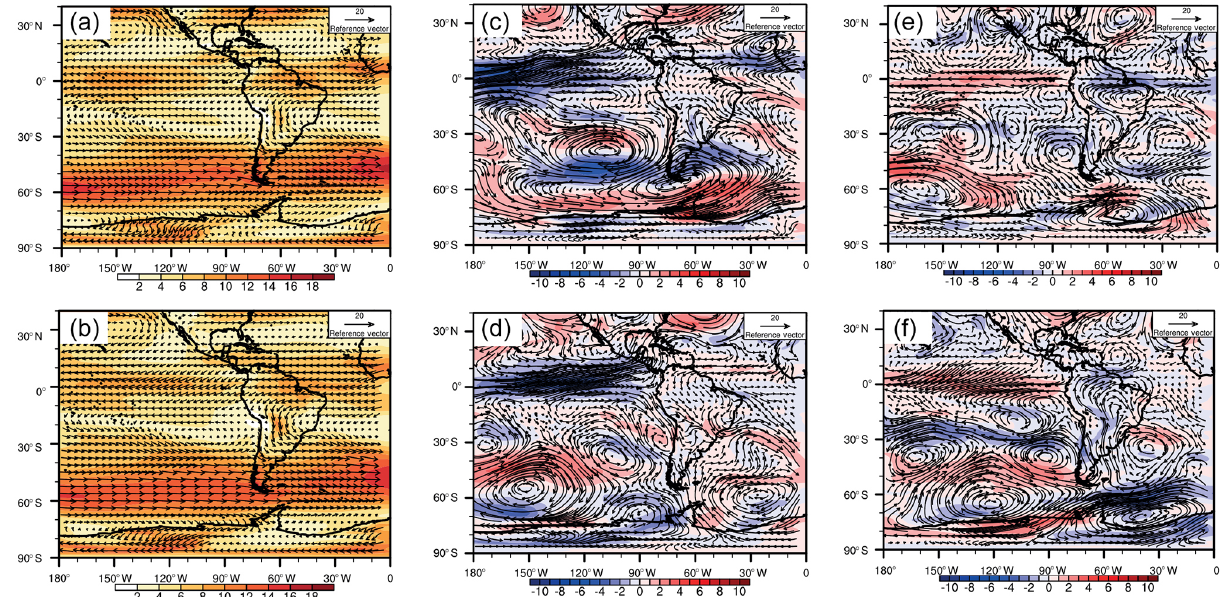
Figure 3. ERAI wind climatology at 700hPa ( a MAM and b SON) and wind change in vector and strength during an exemplary El Niño event (1997–1998) ( c MAM and d SON) and a La Niña event (1988–1989) ( e MAM and f